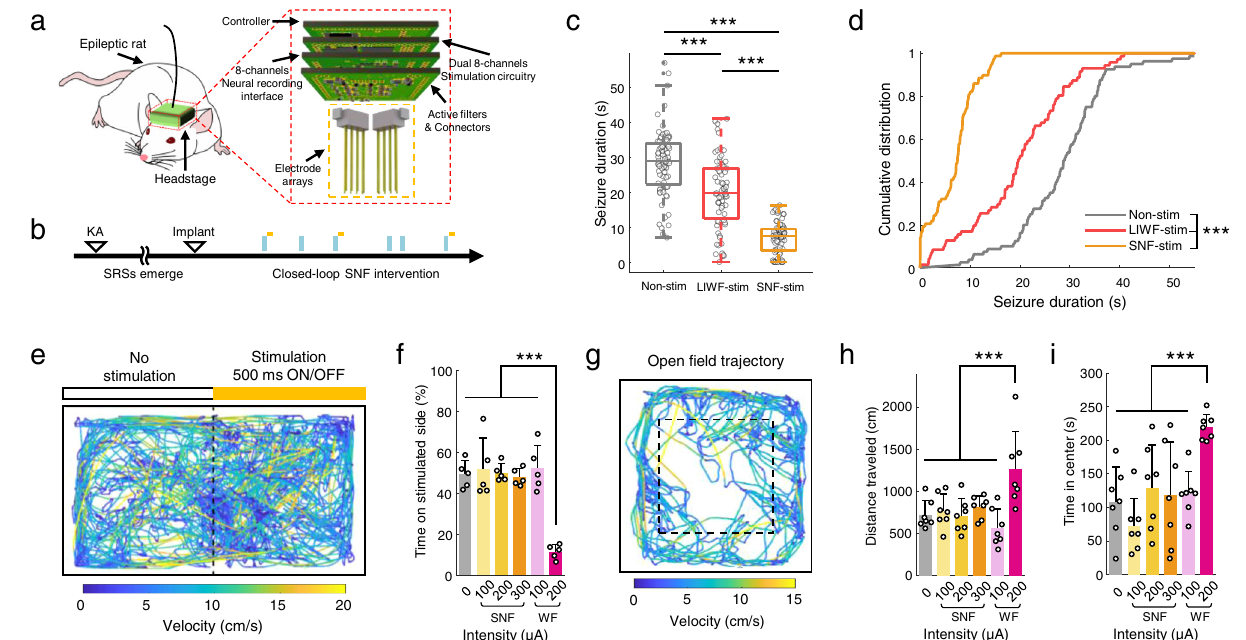
Fig.8 |Chronicseizurecontrolandcognitive-behavioralresponsesduringSNF stimulation. a In vivo chronic experimental setup with implantable stimulator. b Experimental timeline. c Seizure duration in non-stimulation ( n =80 sessions), LIWF stimulation ( n =71 sessions), and SNF stimulation ( n =78 sessions) groups using a chronic seizure model ( P <0.001, one-way ANOVA with Bonferroni cor- rection).Center barindicates median, boxindicates 25th and 75th percentiles, and whiskers extend to the most extreme data points without outliers (±1.5IQR). Out- liers are shown in dot signs. d Corresponding cumulative distributions of seizure duration ( P <0.001 for all comparisons, Kolmogorov – Smirnov test). e Example trajectory of a rat model with SRSs during place preference test in SNF condition. Orange bar indicates stimulation zone. Traces are color-coded for velocity.